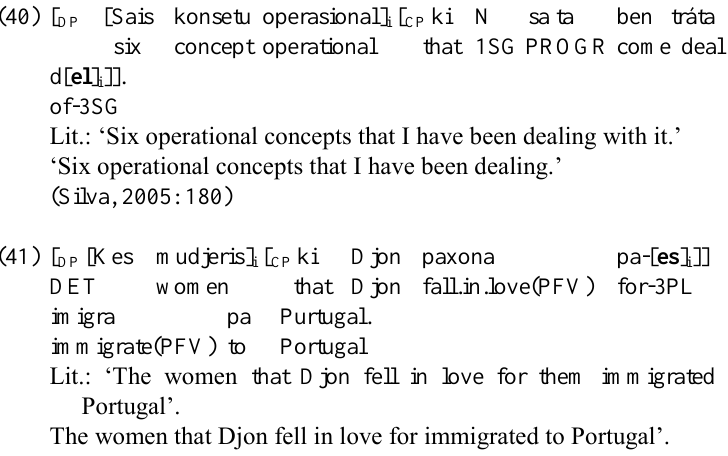
DET table over of which Djon put(PFV) jar have pé kebradu. foot